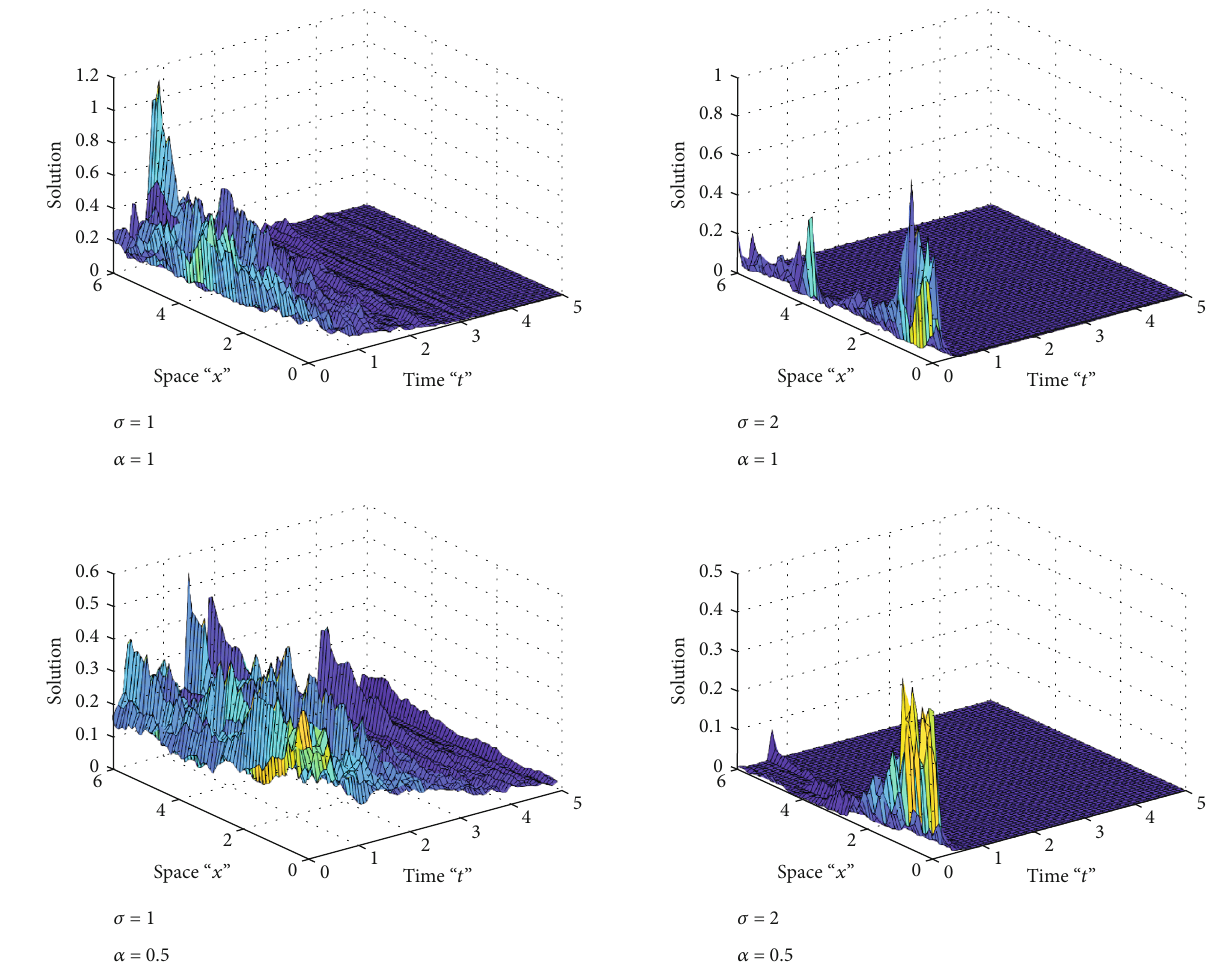
Figure 3: 3D-graph of Equation (33) with σ = 1, 2 and α = 1,0 : 5